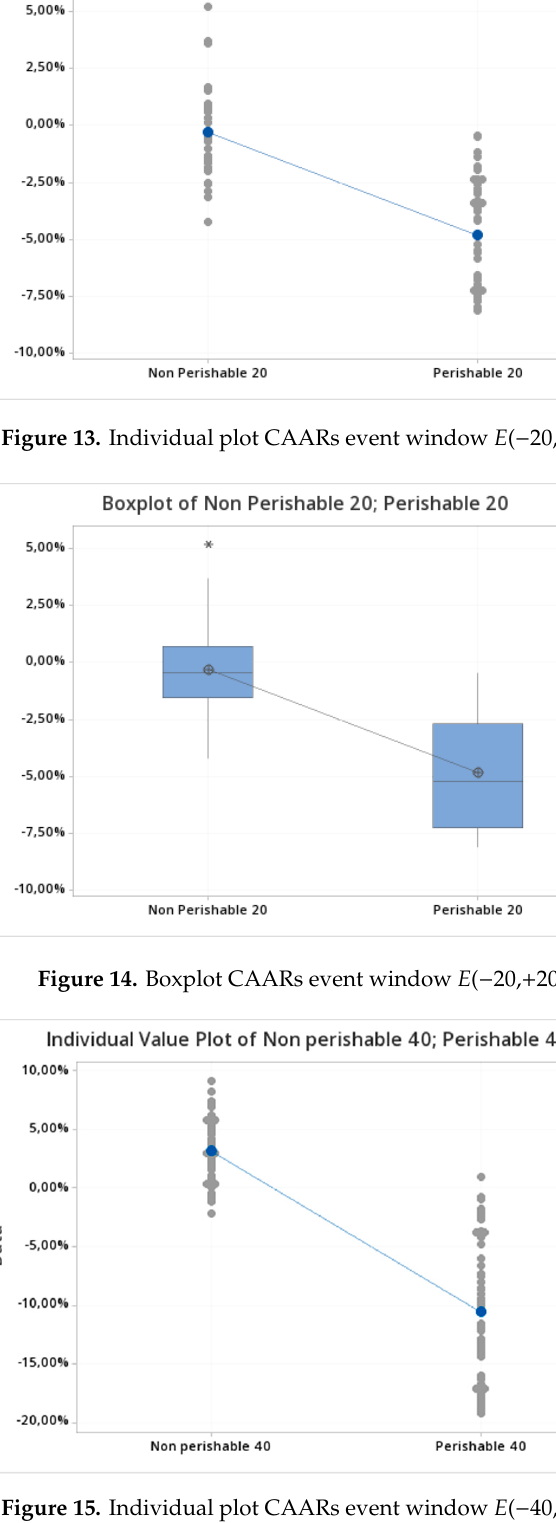
Figure 15. Individual plot CAARs event window E ( − 40,+40).